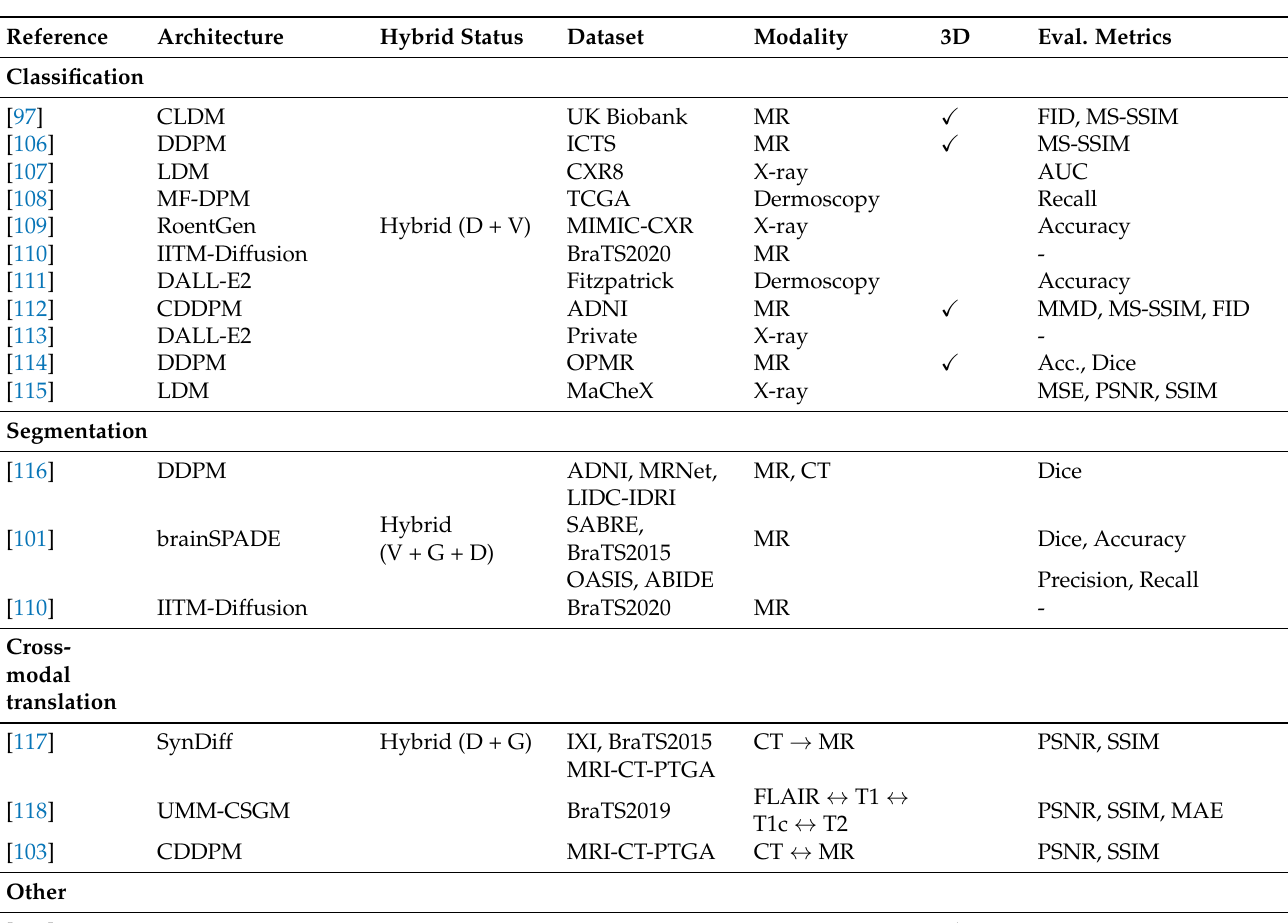
Table 3. Overview of the diffusion-model-based architectures for medical image augmentation that have been published to date (to our knowledge, no such studies were released before 2022). The table includes the reference, architecture name, and hybrid status (if applicable), indicating the combination of VAEs, GANs, and DMs used in each study. The table provides a useful summary of the current state of the art in this area and can help guide researchers in selecting appropriate approaches for their specific